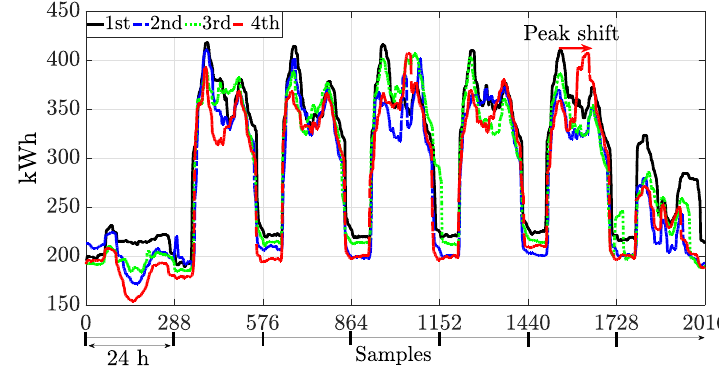
Figure 4. The typical load profile of the business